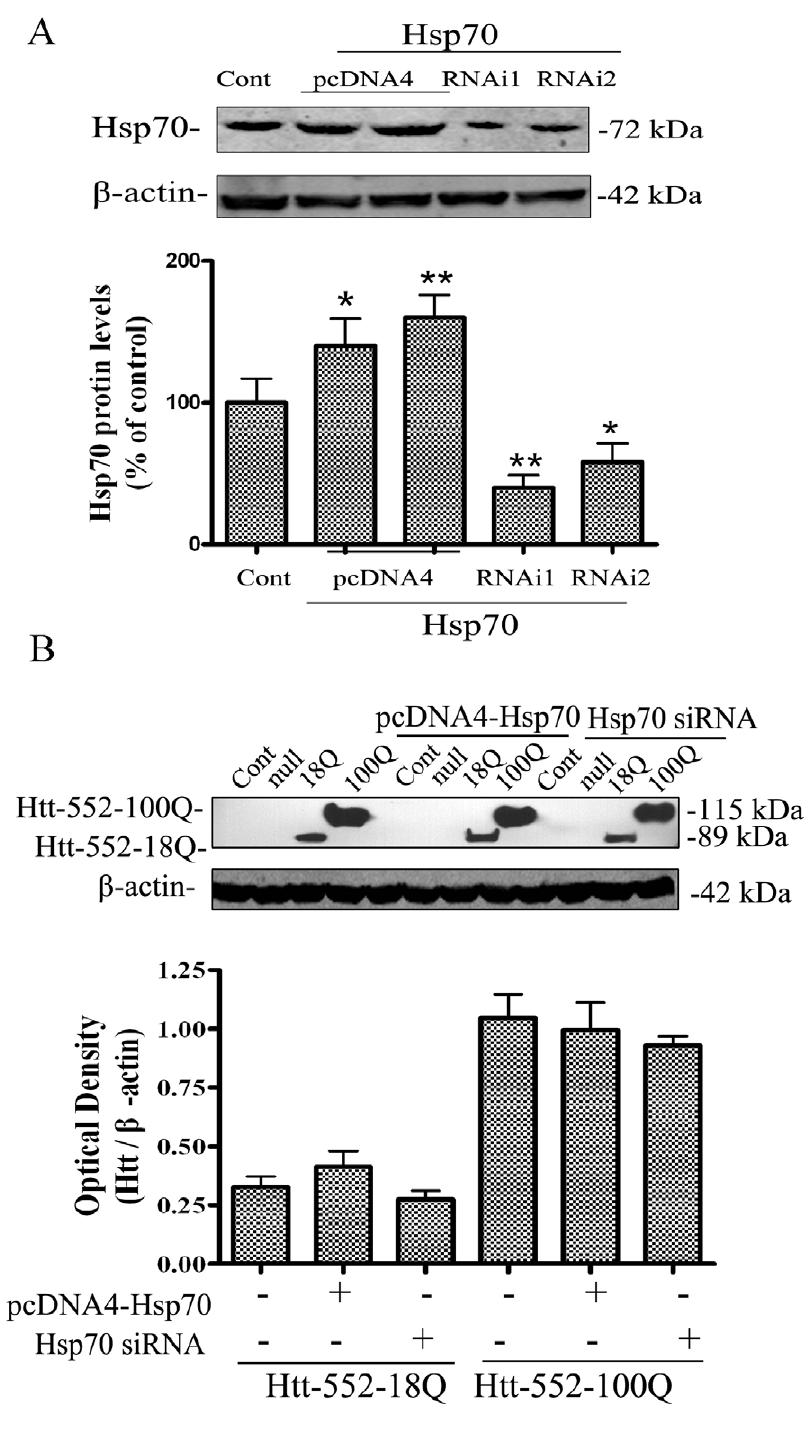
Figure 4. Hsp70 had no affect the clearance of Htt-552. (A) The efficiency of knockdown and overexpression of Hsp. HeLa cells were transiently transfected with Hsp70 plasmid or Hsp70 siRNA for 72 h. Lysates were subjected to Western blot analysis with anti-Hsp70 antibody. Values are the mean 6 SE of three independent experiments. *P , 0.05, **P , 0.01 (vs control). (B) Hsp70 had no effect on Htt-552 levels. HeLa cells were transiently transfected with Hsp70 plasmid, vector control or Hsp70 siRNA for 72 h and Htt-552 for 48 h. Lysates were subjected to Western blot analysis with anti-Htt 2166 and anti–Hsp70 antibodies. Values are the mean 6 SE of three independent experiments. doi:10.1371/journal.pone.0046834.g004 long as starvation persists. The time-course of induction of Beclin 1 CMA with serum removal was supported by the presence of and LAMP-2A was consistent with the activation of macroauto- increased localization of lysosomes to peri-nuclear regions [37]. We found decreased levels of exogenous Htt-552 at 6 h phagy and CMA with different time frames. The activation of